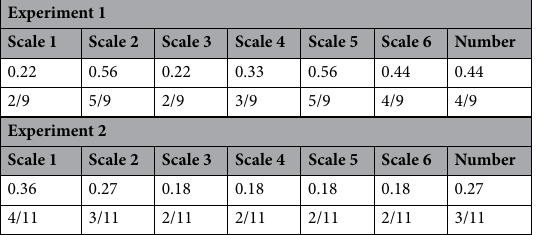
Table 3. Proportion (the number) wherein 95% confidence interval about the difference between an estimate and correct answer contained zero.